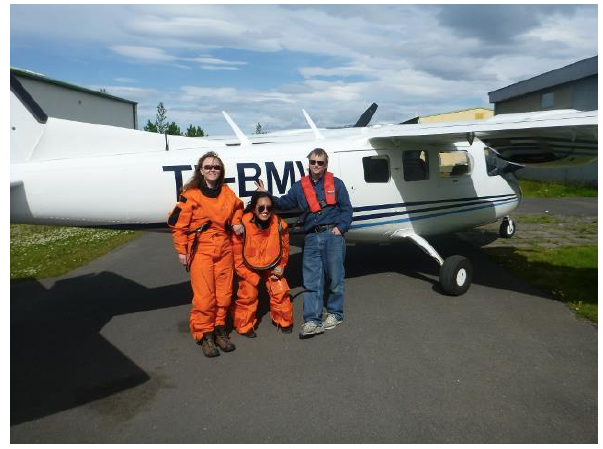
Figure 2. Survey aircraft of the type used in surveys prior to 2016, a Partenavia P-68 Observer, with 1 set of bubble windows at the rear of the plane, shown with the 2015 survey crew. (Photo by Daniel Pike)